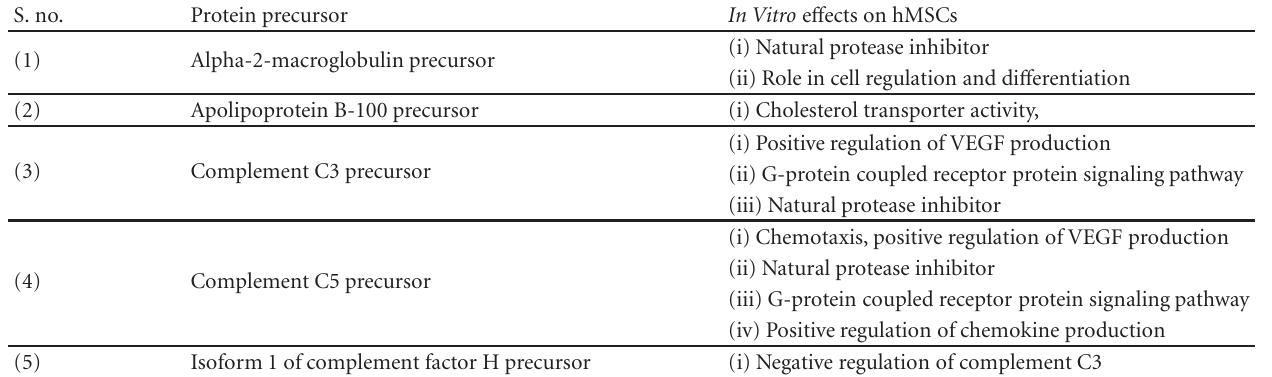
Table 3: Protein precursors abundant in UCBS and their possible functions in in vitro MSC-culture. S.